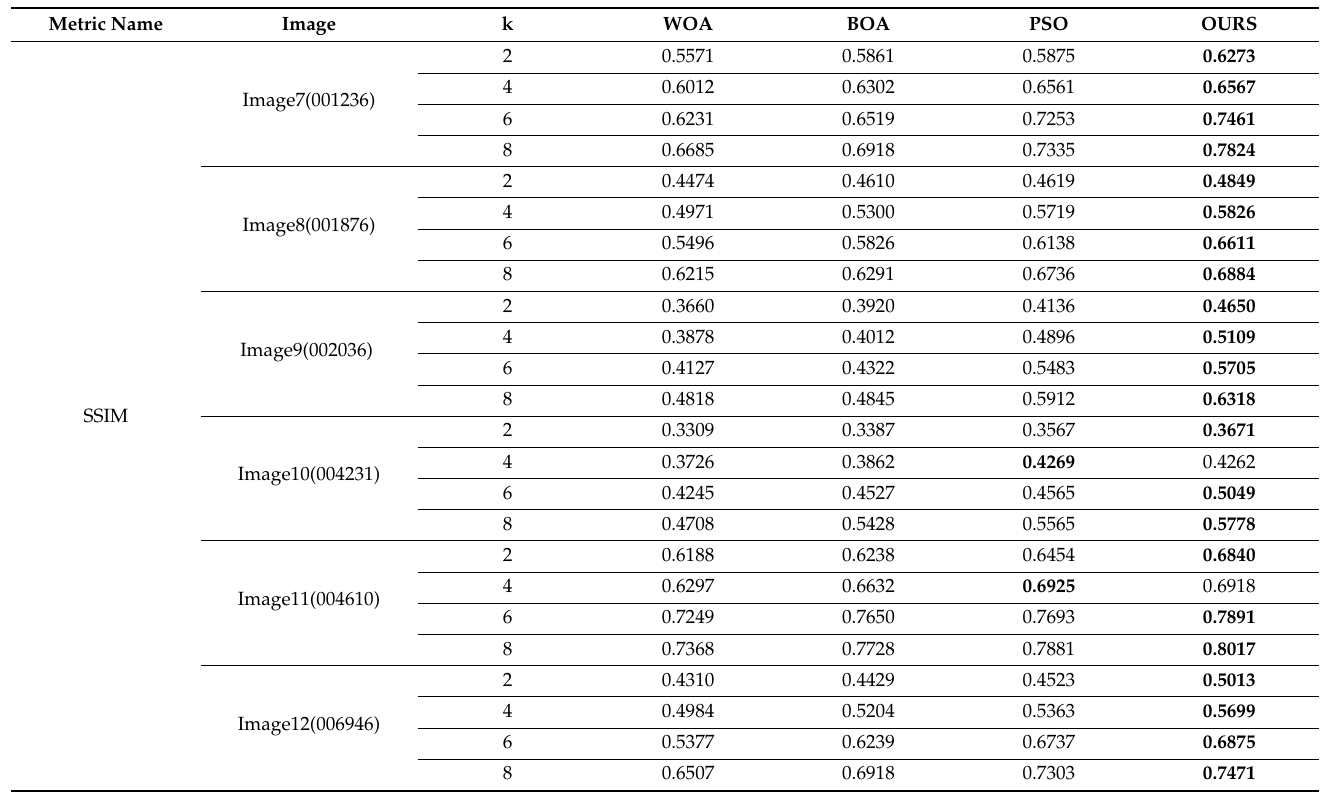
Table 8. Comparison of SSIM in Images